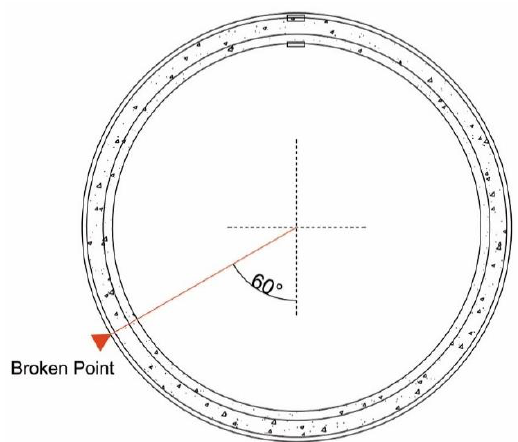
Figure 8. Location of the broken point.